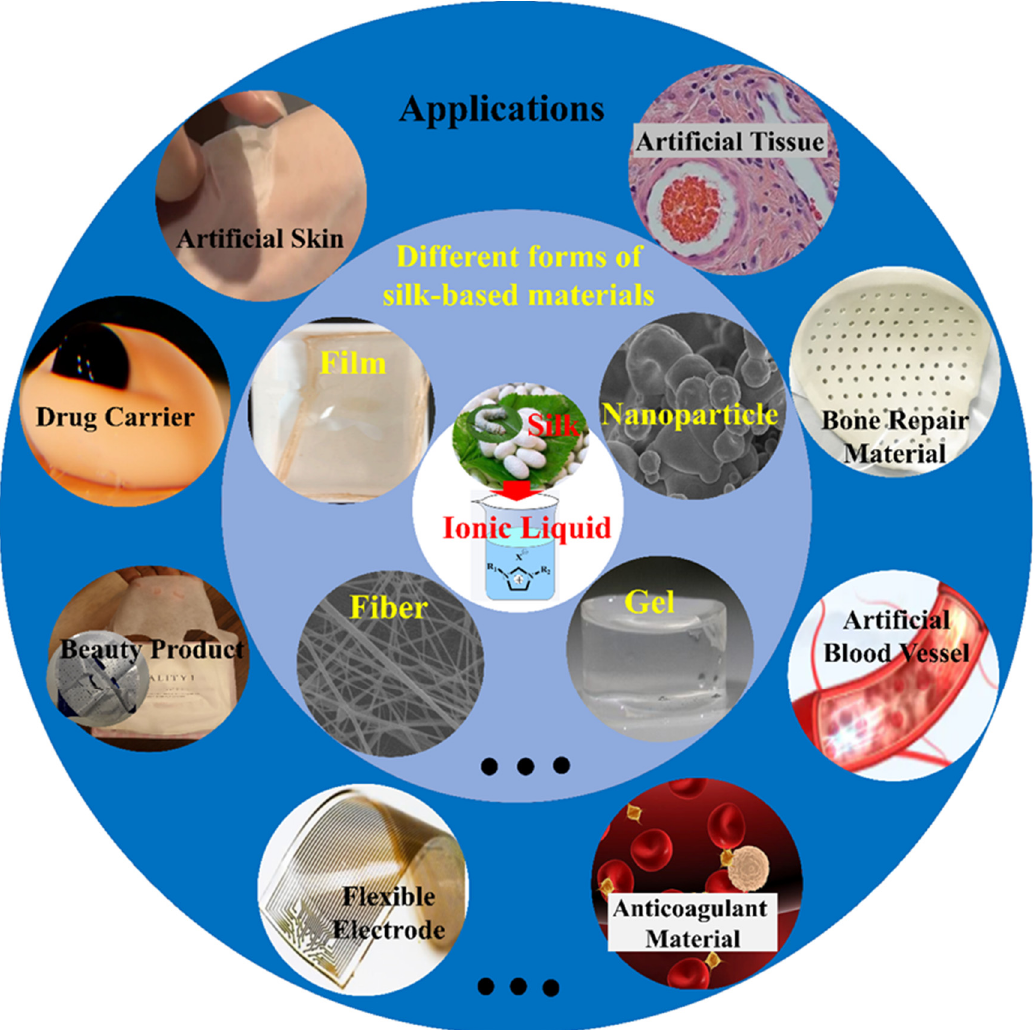
Figure 1. Schematic representation of silk materials and applications after processing with ILs. Silk can be processed into various forms and structures through ILs, such as film, fiber, gel and nano- particle, which are used as artificial skin, drug carrier, beauty products, flexible electrodes, artificial blood vessels and tissue, as well as anticoagulation and bone repair materials.